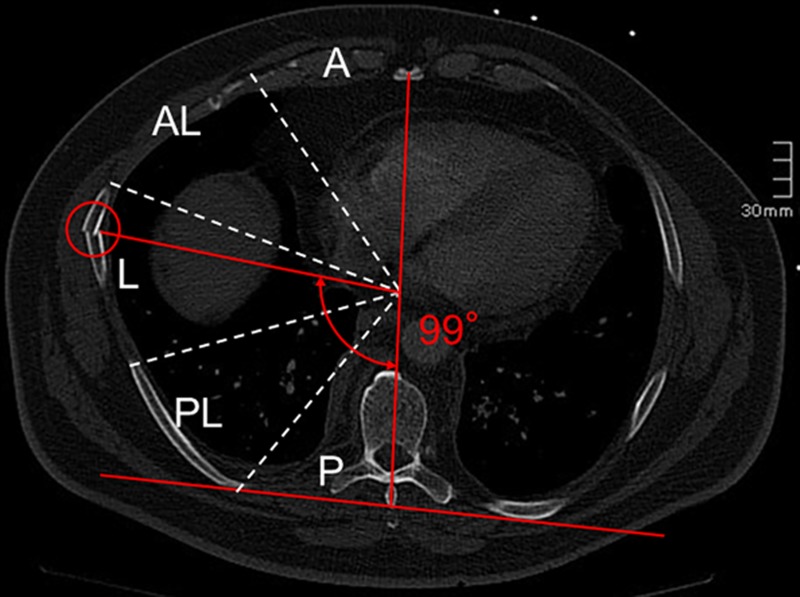
Exemplary illustration of the rib fracture localization using the method of Ritchie et al. (2006).